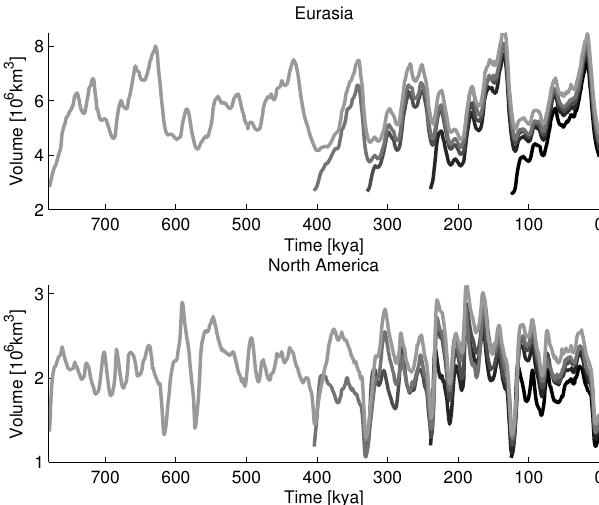
Figure 17. Permafrost volume evolution in simulations initialized with the same initial conditions but started at interglacial periods progressively further back in time. Top: Eurasia; bottom: North